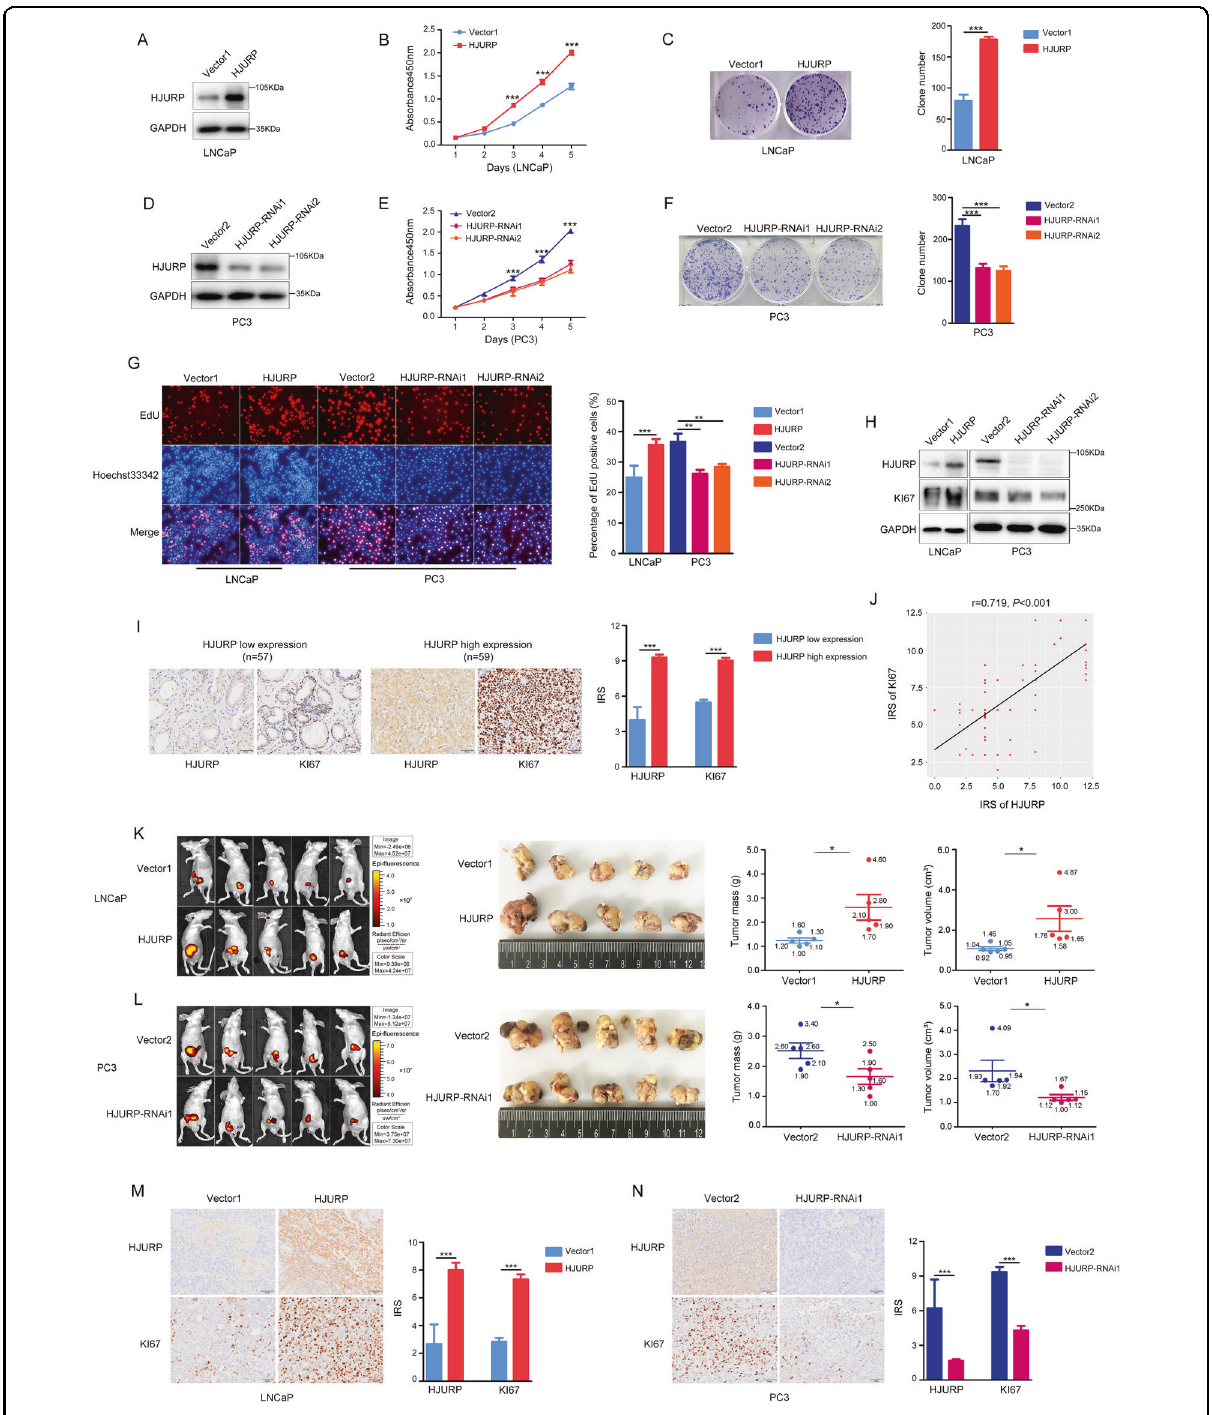
Fig. 3 HJURP promotes the proliferation of PCa cells in vitro and in vivo. A , D Western blotting of HJURP -overexpression ( A ) and knockdown ( D ) ef fi ciency. B , E CCK8 assay to measure PCa cells viability after HJURP -overexpression ( B ) and knockdown ( E ). C , F Colony-formation assay to measure the cell viability of PCa cells after HJURP overexpression ( C ) and silencing ( F ). G EdU assay to measure the effects of HJURP on the proliferative capacity of PCa cells. H Western blotting quanti fi cation of KI67 expression after HJURP overexpression or knockdown in PCa cells. I Representative IHC staining of HJURP and KI67 in different Gleason grade PCa tissues from our hospital ( n = 131, scale bar: 50 µm; magni fi cation: ×200). J HJURP and KI67 protein expression are highly correlated in PCa ( n = 131). K , L HJURP can affect the in vivo growth of PCa cells. M , N Representative IHC staining of HJURP and KI67 in PCa-cell xenograft tissues (scale bar: 50 µm; magni fi cation: